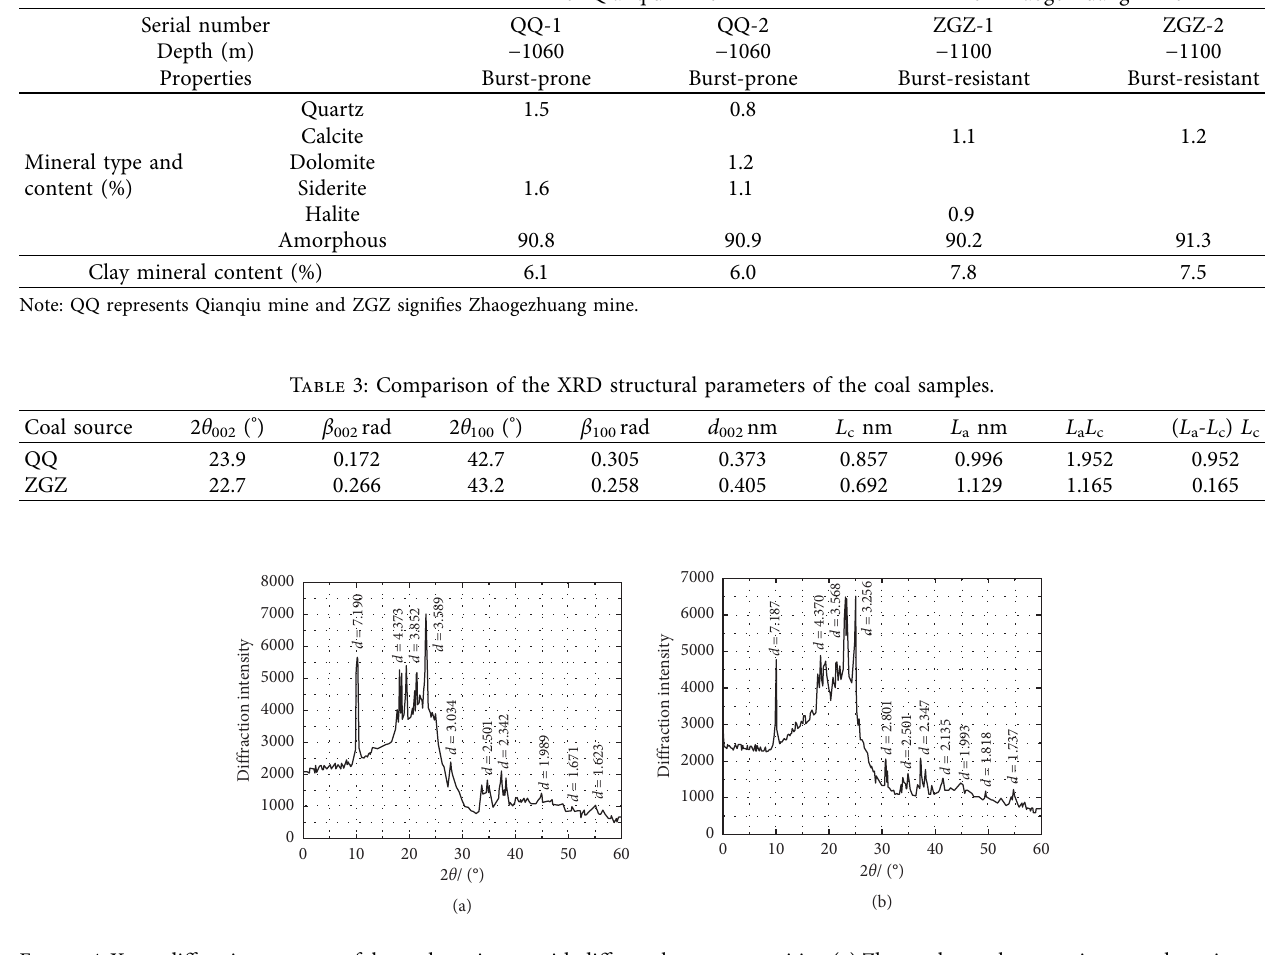
Figure 4: X-ray diffraction patterns of the coal specimens with different burst propensities: (a) Zhaogezhuang burst-resistant coal specimen; (b) Qianqiu burst-prone coal